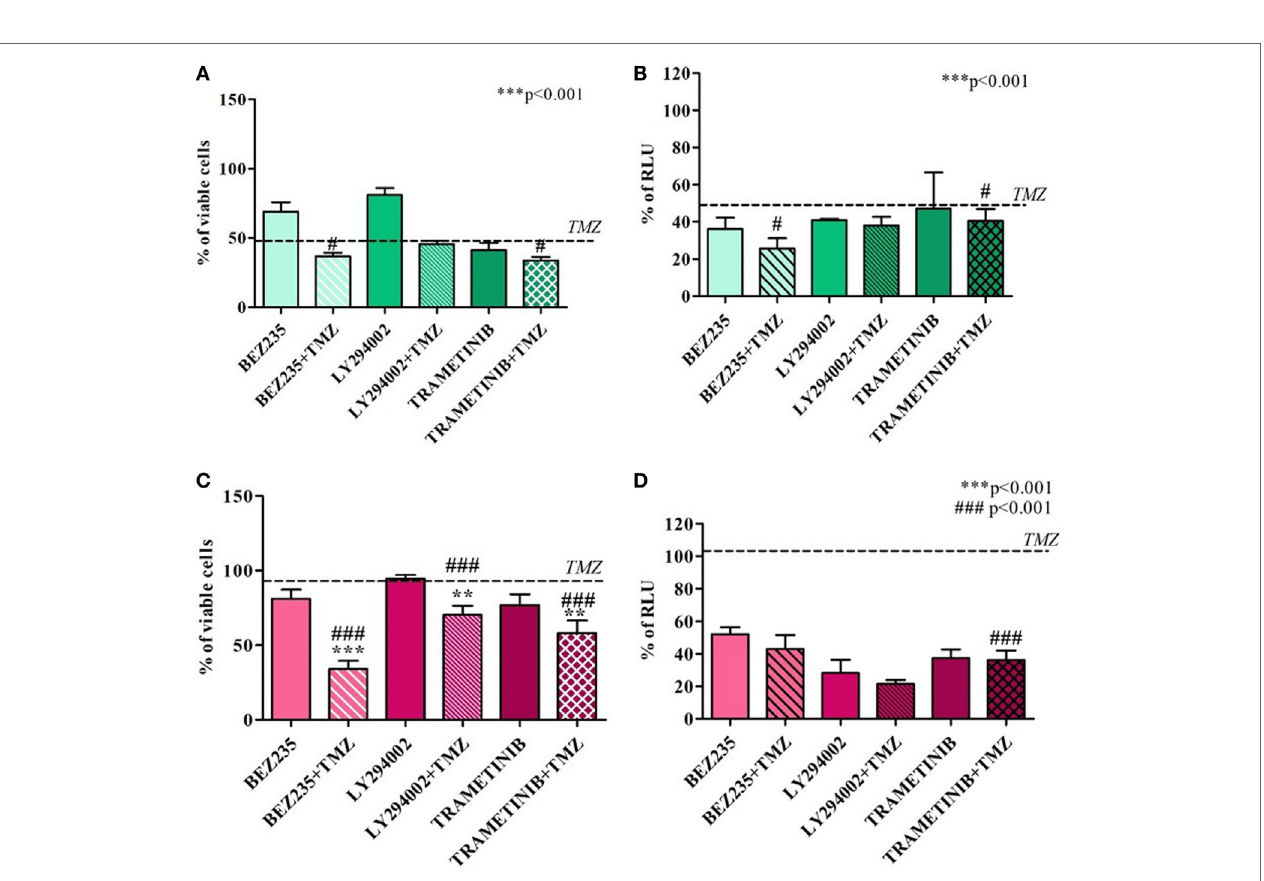
FigUre 4 | Cell viability and hypoxia-inducible factor (HIF)-1 α activity after treatment with different HIF-1 α inhibitors and temozolomide (TMZ). The viability of U251 (a) and T98 (c) was assessed by means of Trypan blue exclusion test and expressed as the percentage of viable cells after HIF-1 α inhibitors. For U251 cells, all treatments are statistically significant vs control cells *** p < 0.001; # p < 0.05; ### p < 0.001 HIF-1 α inhibitors vs TMZ treatment. For T98, ** p < 0.01; *** p < 0.001 treated vs control cells; ### p < 0.001 treatments vs TMZ treatment. HIF-dependent luciferase activity was analyzed in cell lysates, and expressed as the percentage variation in relative luminescence units (RLUs) in U251 (B) and T98 (D) cells. All treatments are statistically significant vs control cells *** p < 0.001; # p < 0.05; ## p < 0.01; ### p < 0.001 HIF-1 α inhibitors vs TMZ treatment.